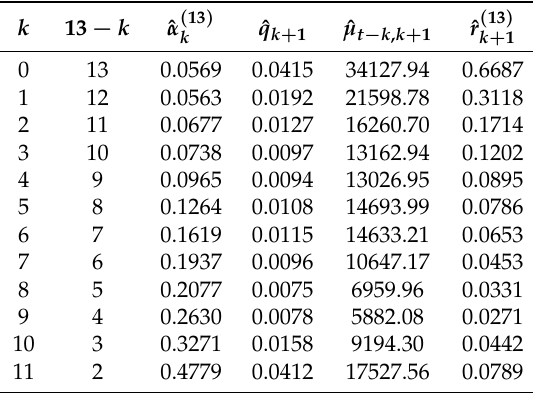
Table 4. Estimation of α , q and µ .